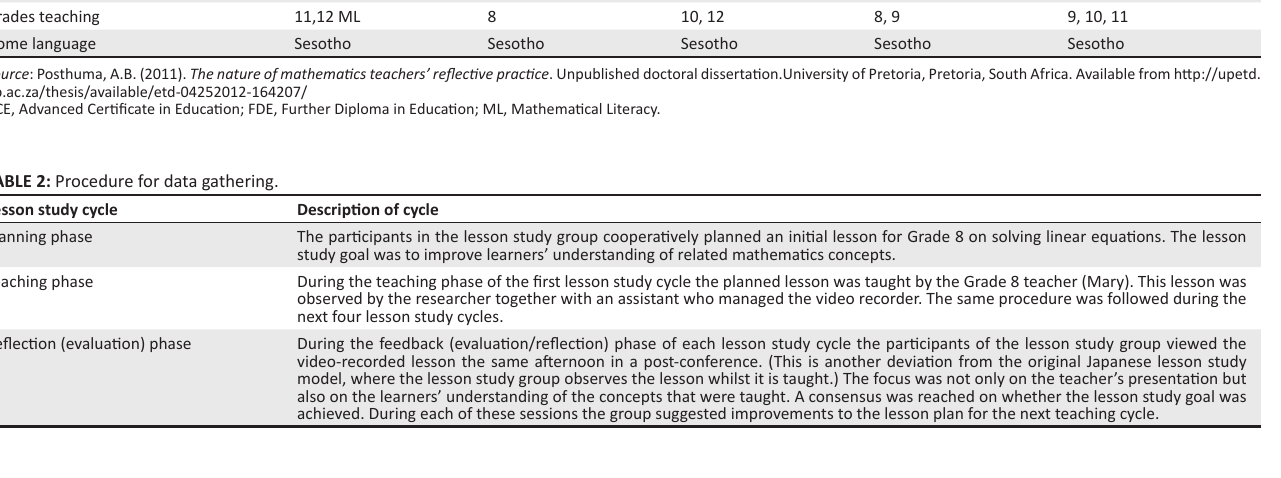
TABLE 1: Biographical information of participants. Category Dianne Mary Age